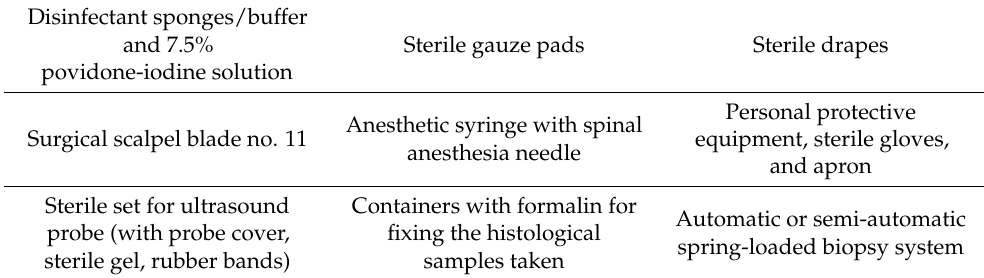
Table 3. Tools of the